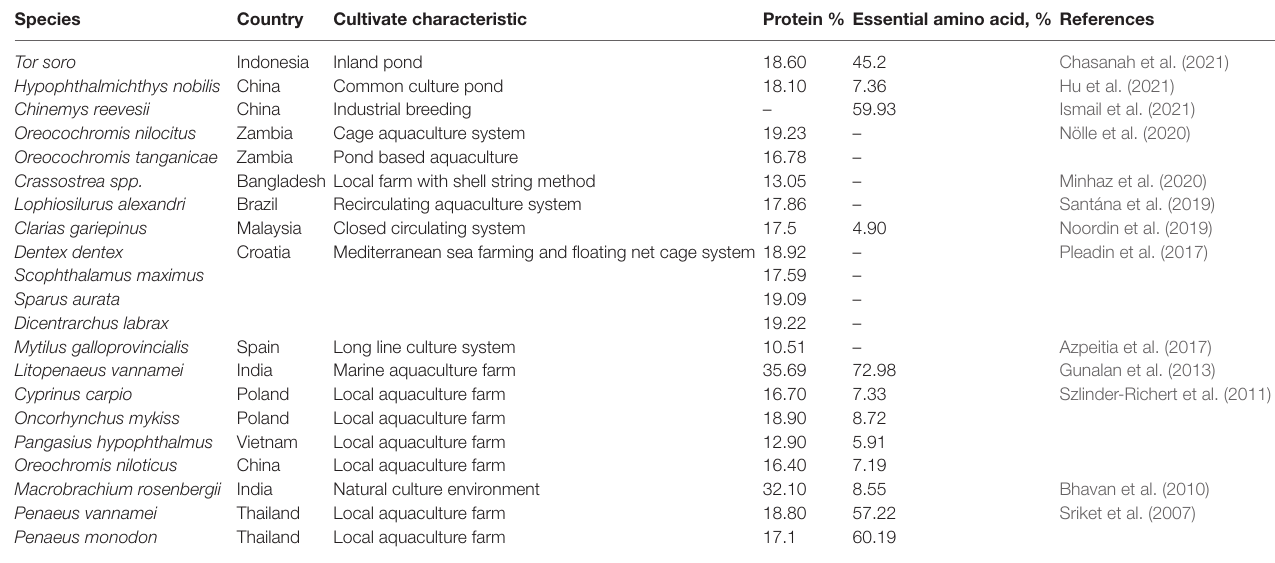
TABLE 1 | Crude protein and essential amino acid (EAA) composition of aquaculture species. Species Country Cultivate characteristic Tor